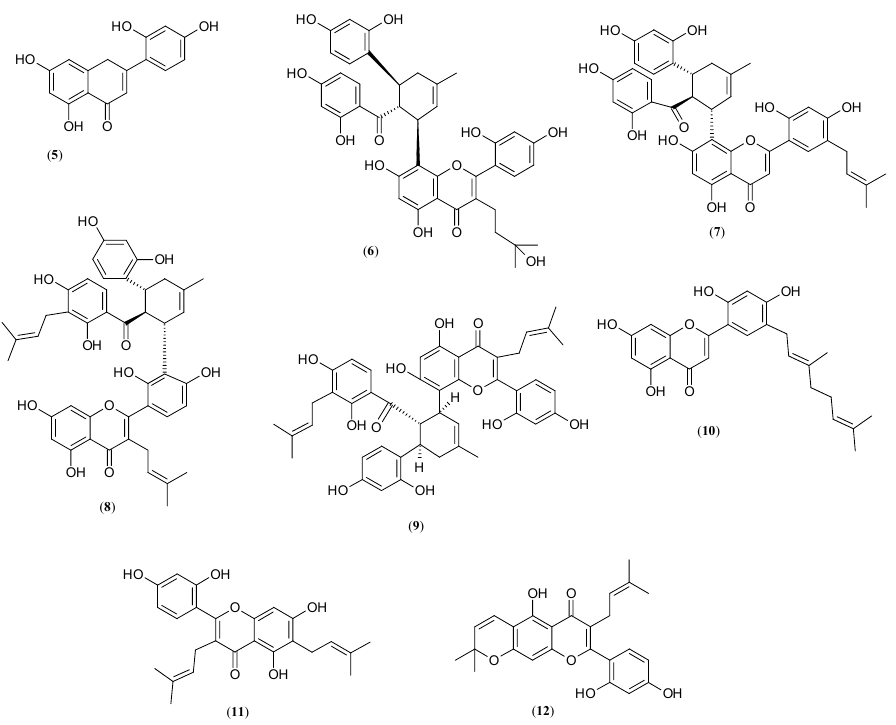
Figure 3. Structures of flavones: norartocarpetin (5 ), moracenin D ( 6 ), kuwanon G ( 7 ), kuwanon N ( 8 ), kuwanon H ( 9 ), 5′-geranyl-5,7,2′,4′-tetrahydroxyflavone ( 10 ), cudraflavone ( 11 ) and cudraflavone B ( 12 ) with tyrosinase inhibitory activity isolated from genus Morus.